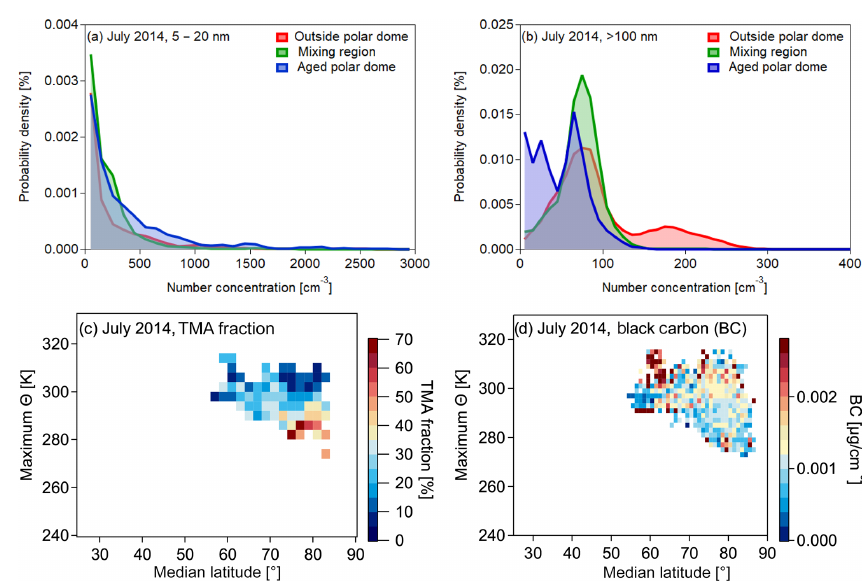
Figure 15. Normalized probability density functions for particles with diameters between 5 and 20nm (a) and larger than 100nm for July 2014 (b) . The color code represents the three different regions identified during the polar dome analysis. Panel (c) shows the distri- bution of the fraction of particles containing trimethylamine with respect to the total amount of particles measured by single-particle mass spectrometry (Köllner et al., 2017) in the maximum potential temperature and median latitude coordinate system. Note that due to particle spectra statistics the resolution of the median latitude and maximum potential temperature interval is reduced compared to the refractory black carbon distribution (BC) shown in panel (d) . There is a slight enhancement in BC south of (80 ◦ N) within the polar dome, which is most probably due to fresh local